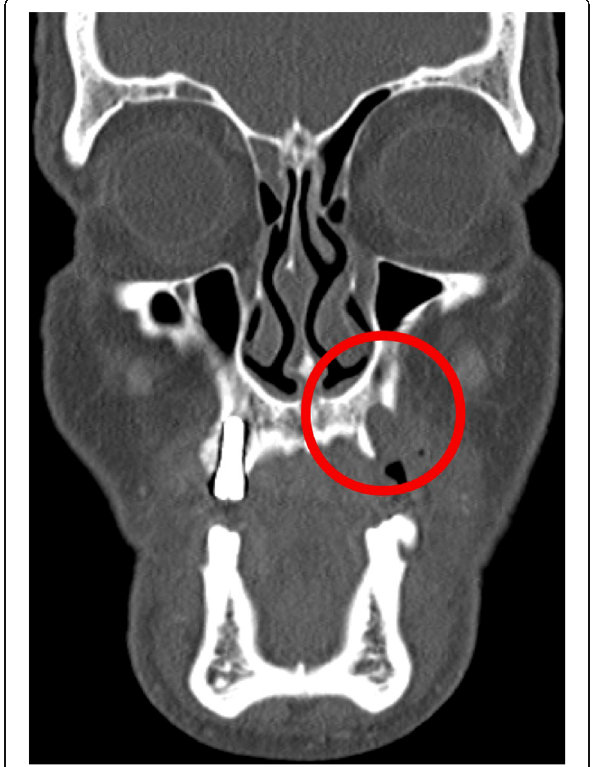
Fig. 1 Pt no. 1. CT scan showing a radiolucent area involving the socket of tooth 24 and the surrounding